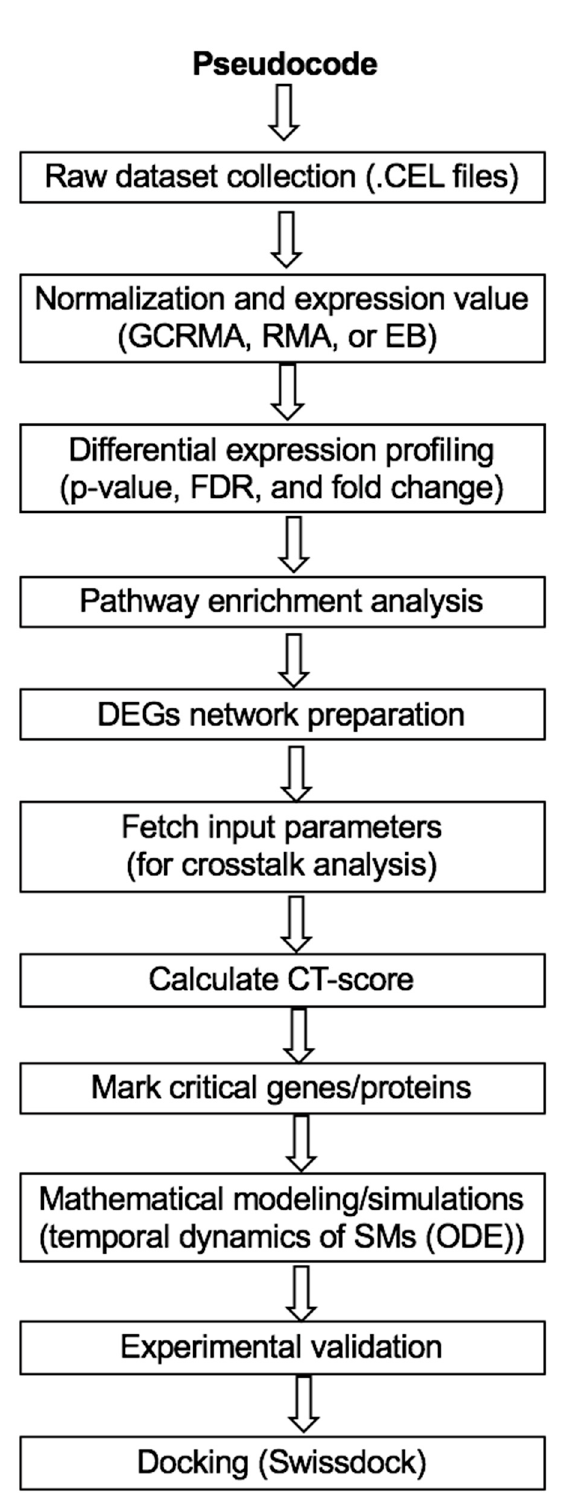
Figure 2. Pseudocode for carry out the entire work presented in this